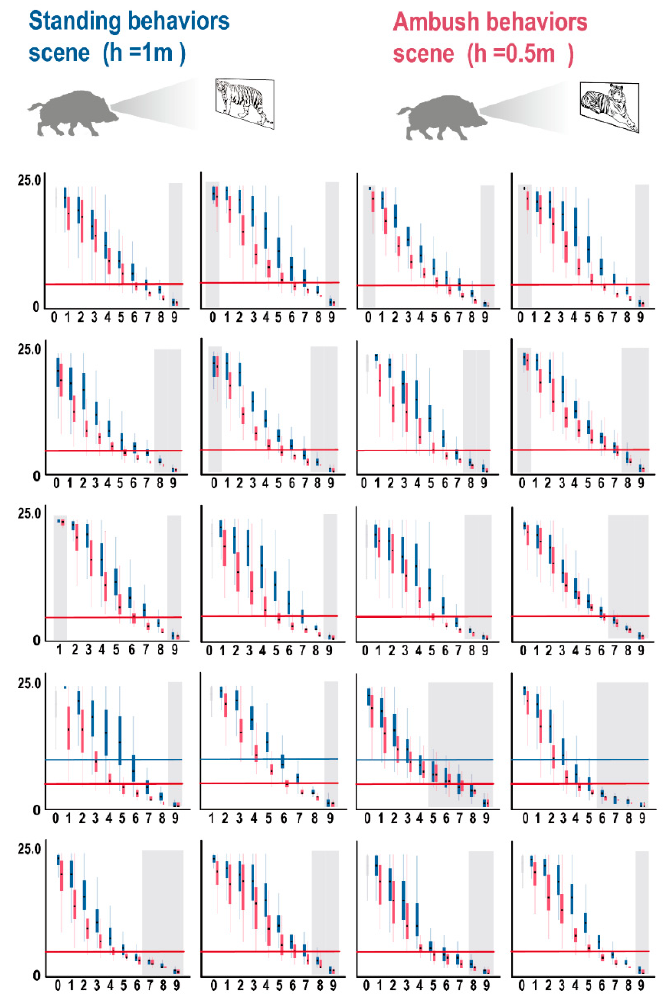
Figure 5. Ambush behaviors can be closer to the wild boar than the standing behaviors. Blue represents the standing behaviors; red represents the ambush behaviors. Gray shade indicates that the two groups of data are not significantly different ( p > 0.05). The red line is 5 m, the blue line is 10 m. Within 5 m, ambush behaviors no longer brought tigers closer to the nest.